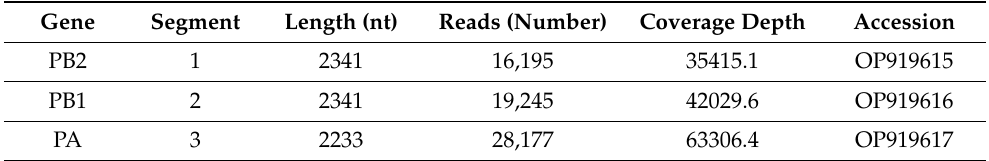
Table 1. Number of reads obtained and depth of coverage per genome segment for strain A/equine/Bari/2005 by